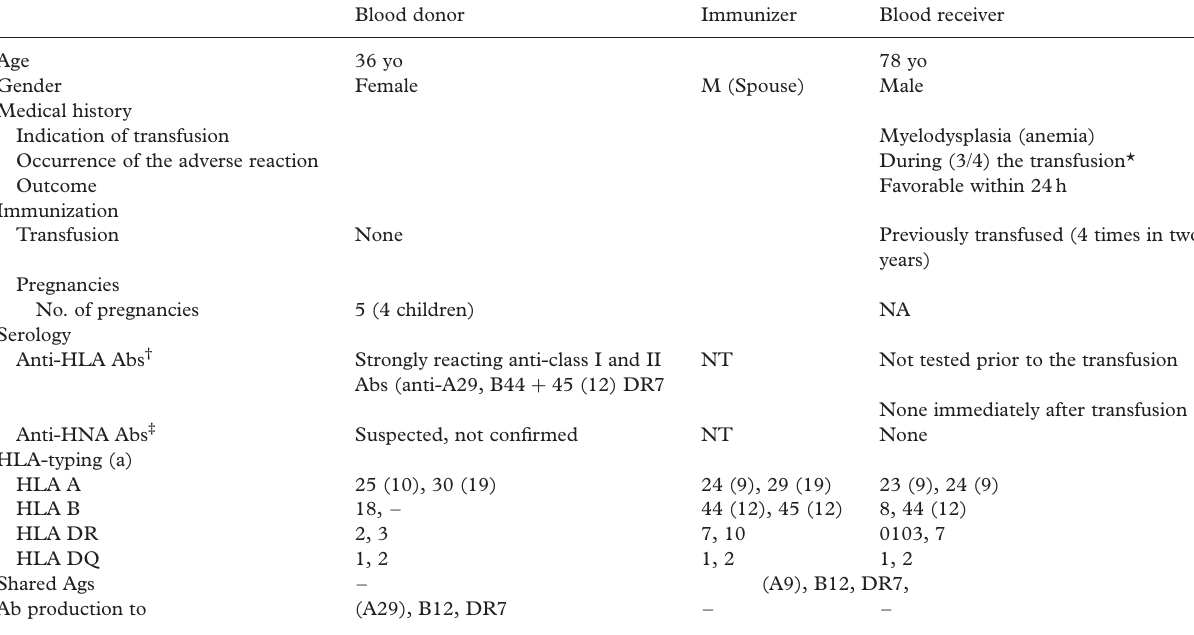
Table I. Case report 1 on the occurrence of TRALI after transfusion of packed red blood